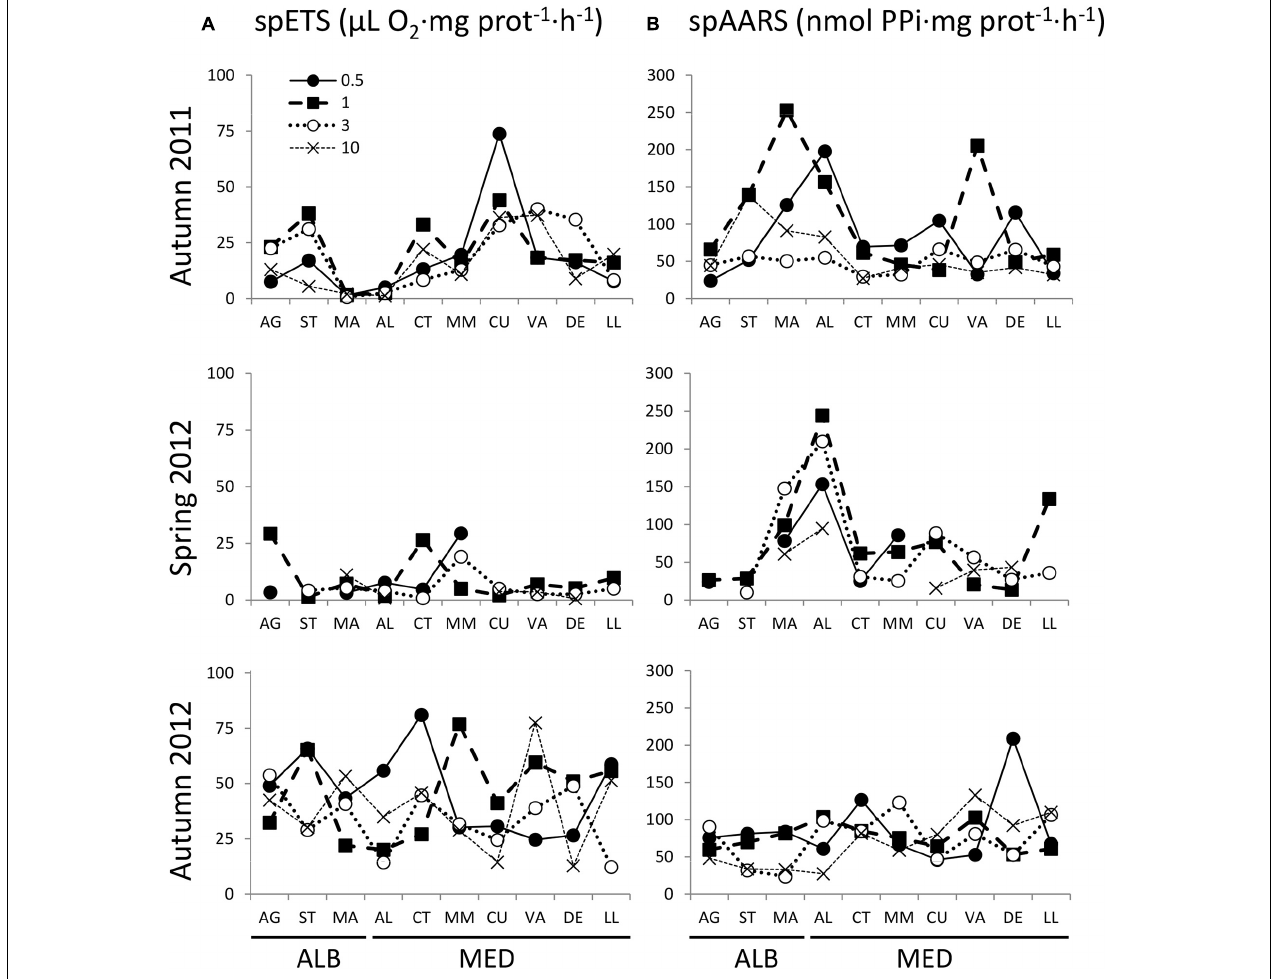
FIGURE 5 | Mesozooplankton community (A) spETS situ ( µ L O 2 · mg prot − 1 · h − 1 ) and (B) spAARS situ (nmol PPi · mg prot − 1 · h − 1 ), from AG to LL at 0.5, 1, 3, and 10 km distance from the coast in autumn 2011, spring 2012, and autumn 2012. Transect codes as in Figure 1